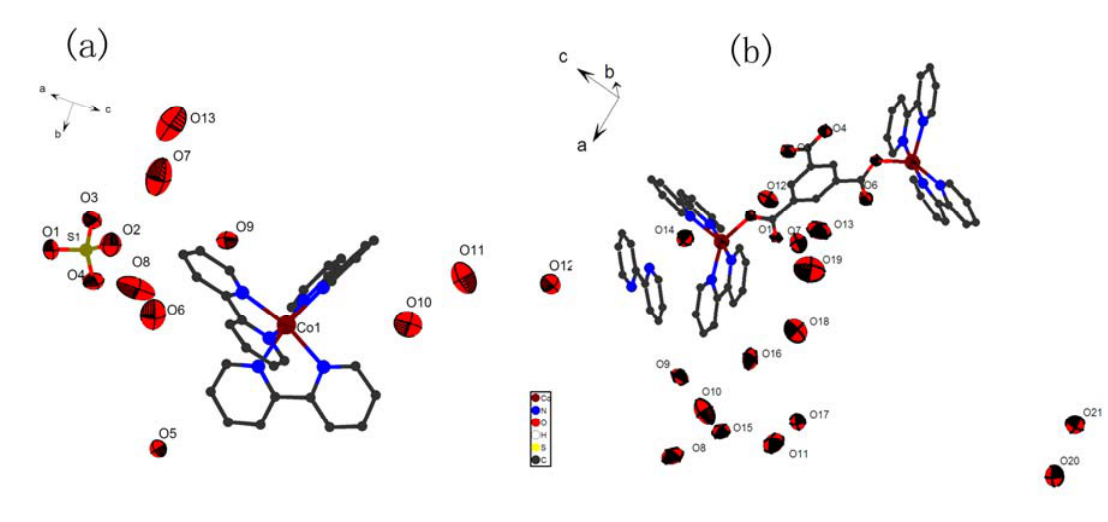
Figure 1. (a) The coordination environments of Co atoms with 50% thermal ellipsoids of complex 1 . (b) The coordination environments of Cu atoms with 50% thermal ellipsoids of complex 2